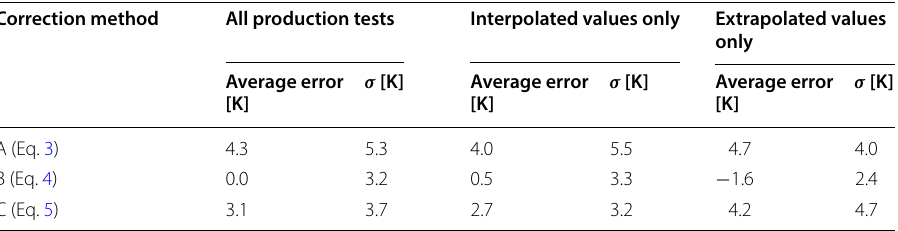
Table 1 Temperature differences to production test data for the three correction methods analysed. The average error as well as the standard deviation ( σ ) are shown. To highlight potential shortcomings of each method, separate statistics are exhibited for data which were interpolated from corrected logs and those which had to be extrapolated as the production test was in a larger depth than the final log measurement Correction